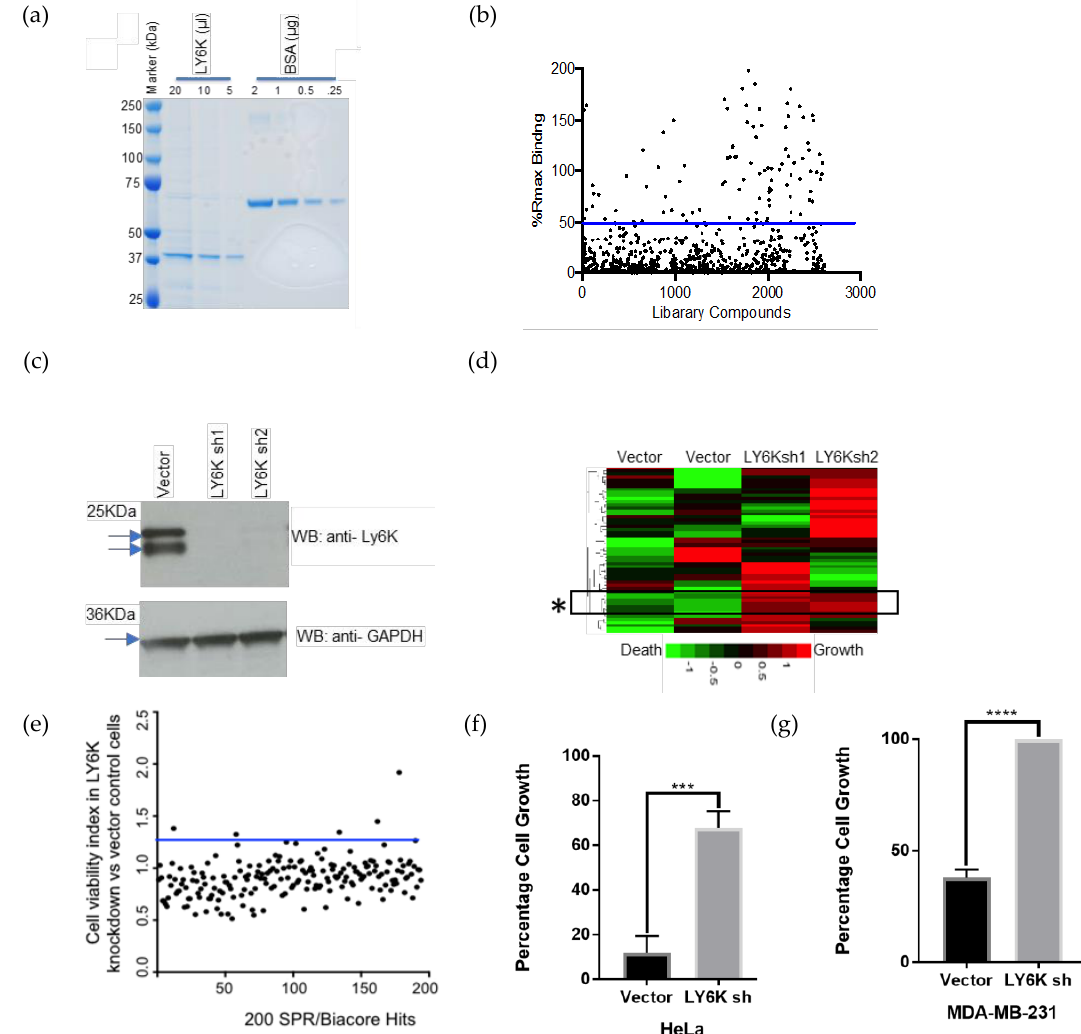
Figure 2. Identification of NSC243928 as a binder of LY6K. ( a ) Full-length GST-tagged LY6K protein was overexpressed in HEK 293 cells. GST sepharose beads were used to pull down the protein and were run on SDS-PAGE gel alongside BSA. ( b ) Surface plasmon resonance (SPR) data showing binding of NCI Developmental Therapeutics Program (DTP) small molecules to recombinant full-length LY6K. The Y axis is normalized to R max , which is the theoretical maximum signal that can be achieved based amount of protein immobilized on the chip surface. Blue line indicates the 50% threshold. ( c ) Western blot data validating LY6K knockdown compared to vector control in HeLa cells. A sheep anti-human LY6K antigen affinity-purified polyclonal antibody (R&D Systems #AF6648) was used. Two specific bands centered around 25 kDa are standard for this antibody for full-length LY6K [13]. ( d ) Differential drug assay on HeLa control and LY6K knockdown cells. A total of 180 compounds showed binding to LY6K over control. These compounds were tested in cell growth assay in duplicate. The subset of drugs with a lower activity corresponding to the loss of LY6K are indicated by ‘ * ’ . ( e ) Cell viability fold change between LY6K shRNA and control HeLa cells. ( f ) HeLa Vector and sh2 Cell-Titer-Blue assay. HeLa cells were treated with 2 μM NSC243928. After 24 h, cell viability was assessed (*** indicates p < 0.001). ( g ) MDA-MB-231 Vector and sh2 Cell-Titer-Blue assay. MDA-MB-231 cells were treated with 2 μM NSC243928 . Cell viability was assessed after 24 h of treatment (**** indicates p < 0.0001).